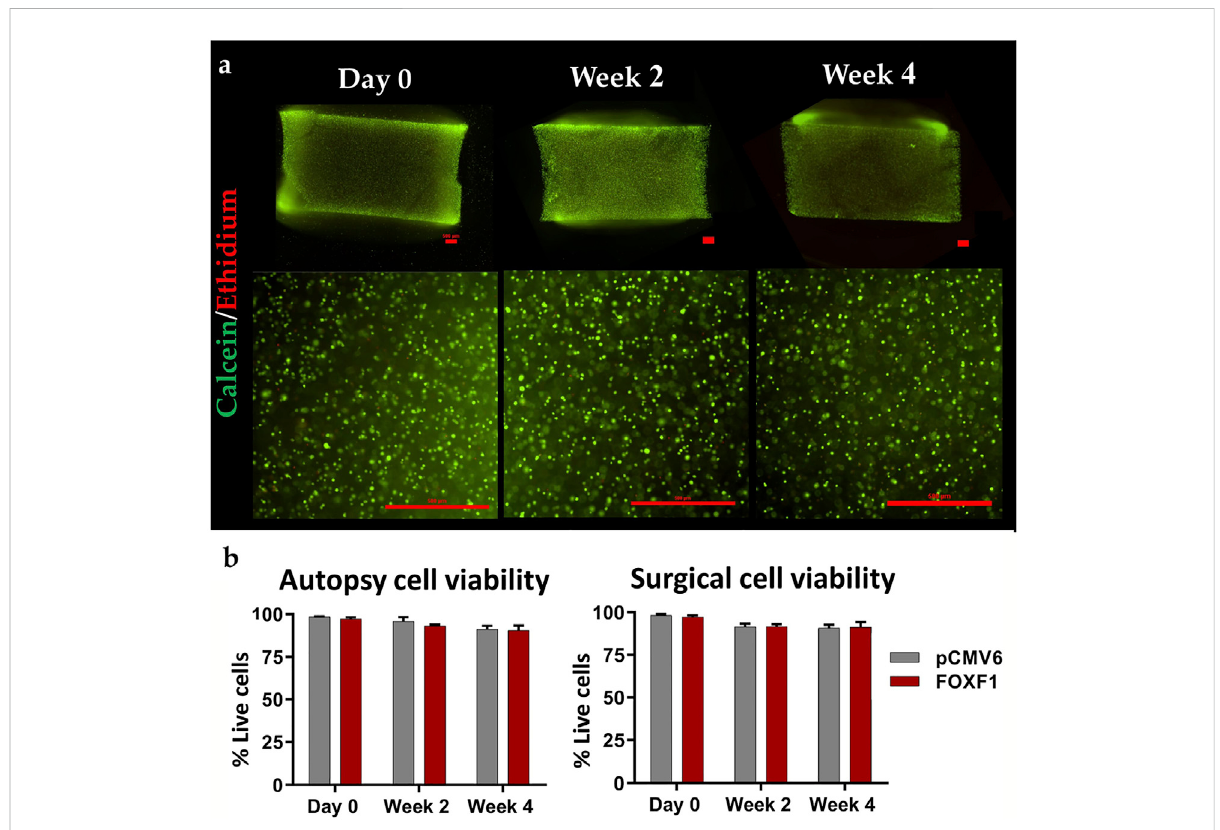
FIGURE 3 Representative4×(top)and10×(bottom)stainedimages(scalebar:500 μ m)ofgelsagittalfrozensectionscontaininghumanNPcellsatday0, week 2 and 4 weeks in culture (A) ; green represents cells that survived after electroporation transduction, and red represents cells that died after electroporation.Theliverate ofcells transfected withFOXF1andpCMV6byelectroporationintheautopsygroupandsurgery groupwerequanti fi ed (B) . Reprinted permission by CC BY license (Tang et al., 2021c).